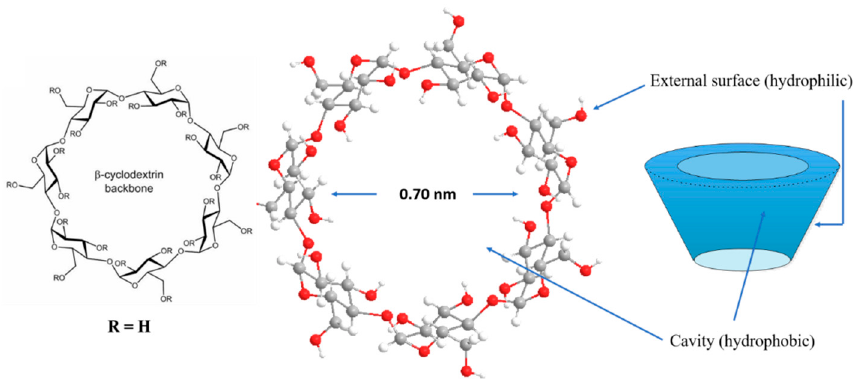
Figure 1. Structure of β -cyclodextrin.